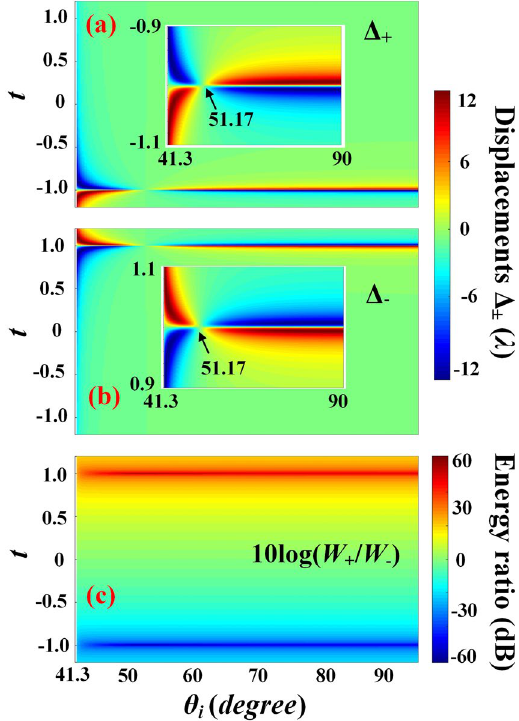
Figure 5. The changes of the SDDs Δ + ( a ) and Δ − ( b ) as functions of the incident angle θ i and the initial amplitude ratio t , when Δ δ = π /2. ( c ) The corresponding energy ratio between the RCP and LCP components 10 log( W + / W − ). Insets in ( a ) and ( b ) zoom in the ranges of t between − 1.1 and − 0.9 and 0.9 and 1.1, respectively.